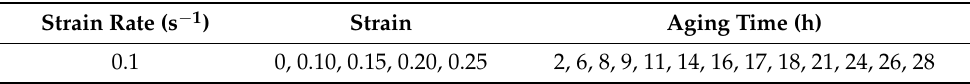
Table 2. Other deformation and aging parameters.